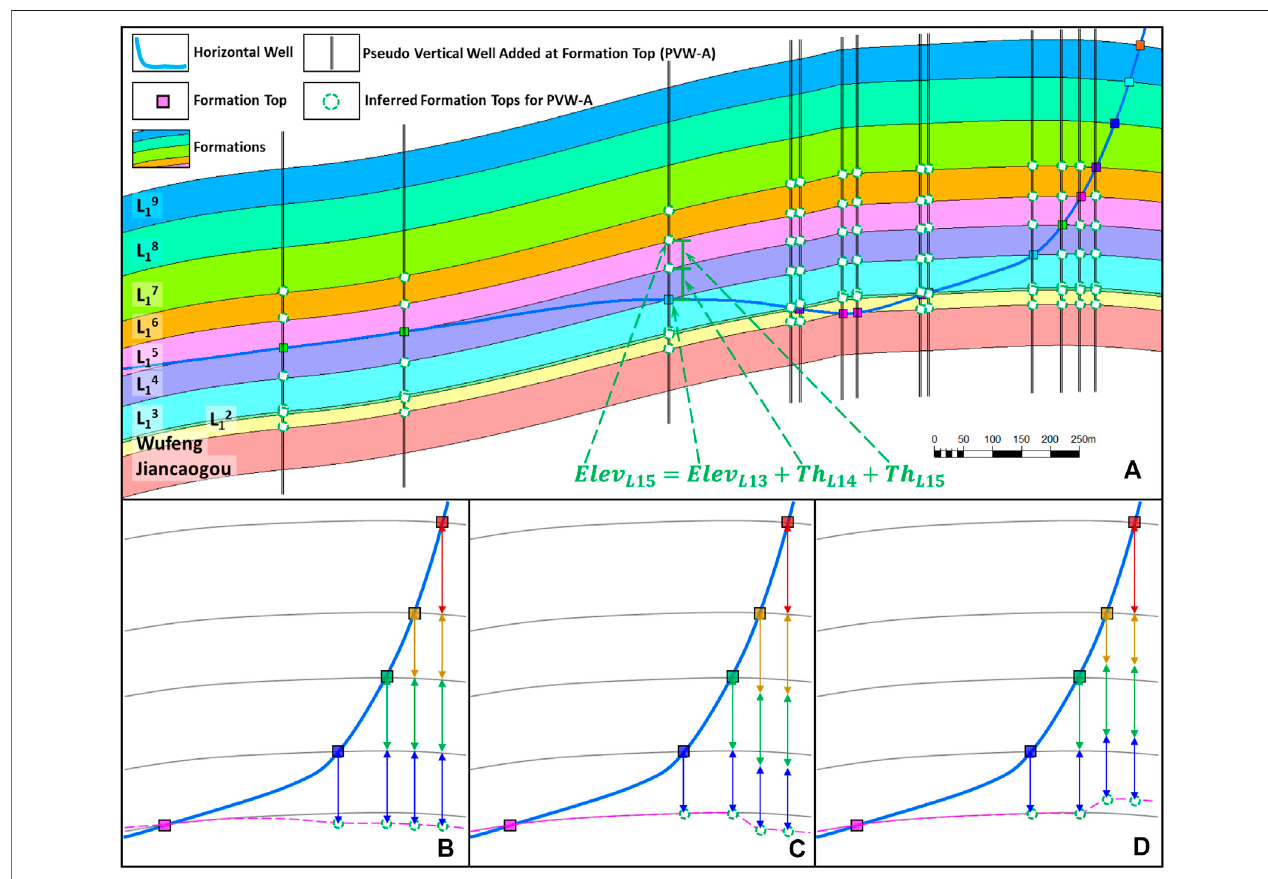
FIGURE3| Pseudoverticalwellsaddedatformationtops(PVW-A)forthewellJY-aintheJiaoshibaarea,SichuanBasin (A) andtheeffectsofshalelayerthickness on formation top elevation calculation (B – D) .